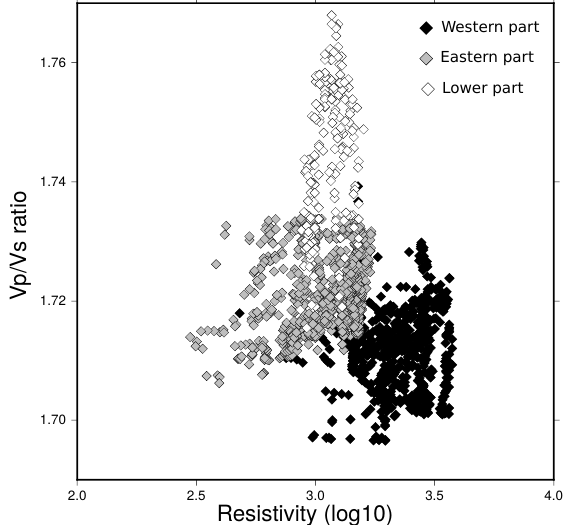
Figure 6. Vp/Vs ratio vs resistivity values (log10) for the resistive structure R 2 (white diamonds in Figure 5). Each color corresponds to a specific portion of R 2 , discussed in the